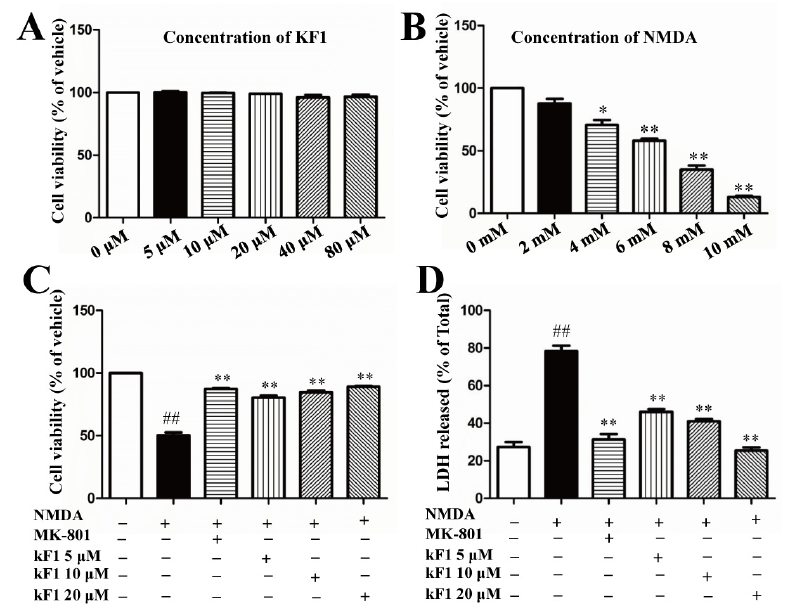
Figure 1. KF1 inhibited NMDA-induced neurotoxicity. ( A ) The cytotoxicity of KF1 in 24 h. The data represent mean ± SEM ( n = 10). ( B ) The cell viability of NMDA-treated cells after 6 h; * p < 0.05; ** p < 0.01 versus 0 mM group. ( C ) The protection of KF1 against NMDA-induced neurotoxicity. ## p < 0.01 versus vehicle group; ** p < 0.01 versus NMDA group. ( D ) The release of lactate dehydro- genase (LDH). The data represent mean ± SEM ( n = 8). ## p < 0.01 versus vehicle group; ** p < 0.01 versus NMDA group.